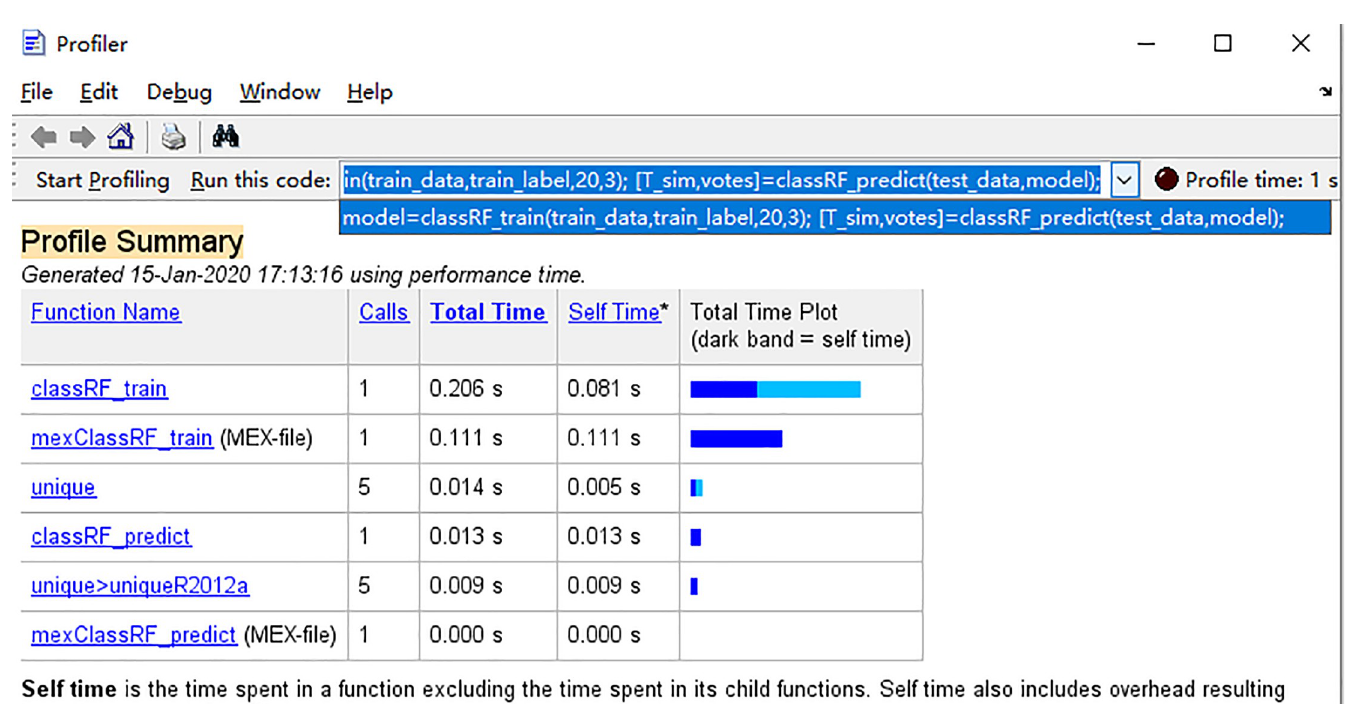
Fig 23. Sample test time.